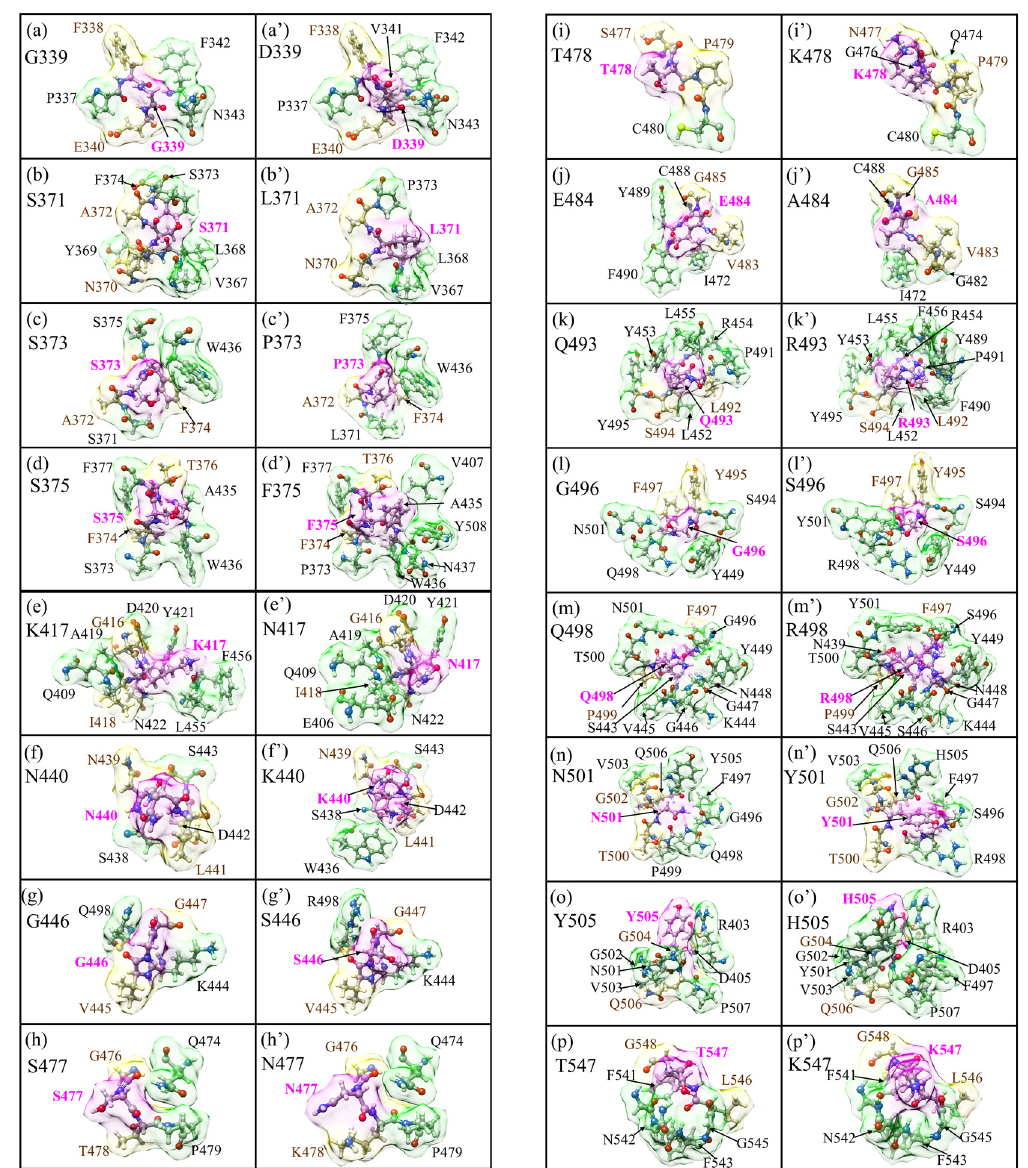
Figure 4. Details of the shape change of AABPU of the sixteen mutation sites in RBD–SD1( from reference [31]): ( a ) G339; ( b ) S371; ( c ) S373; ( d ) S375; ( e ) K417; ( f ) N440; ( g ) G446; ( h ) S477; ( i ) T478;